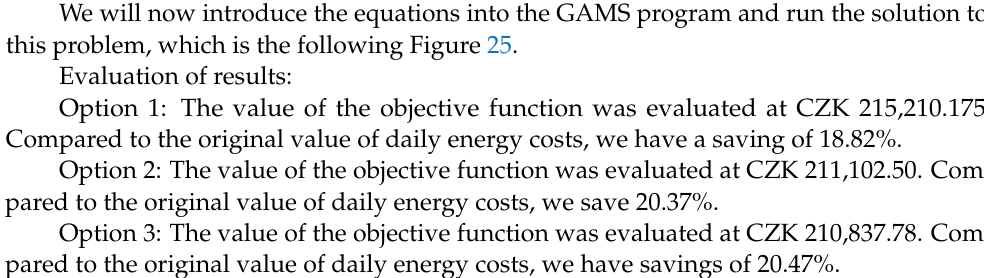
Figure 24. Variables of the default mathematical model.